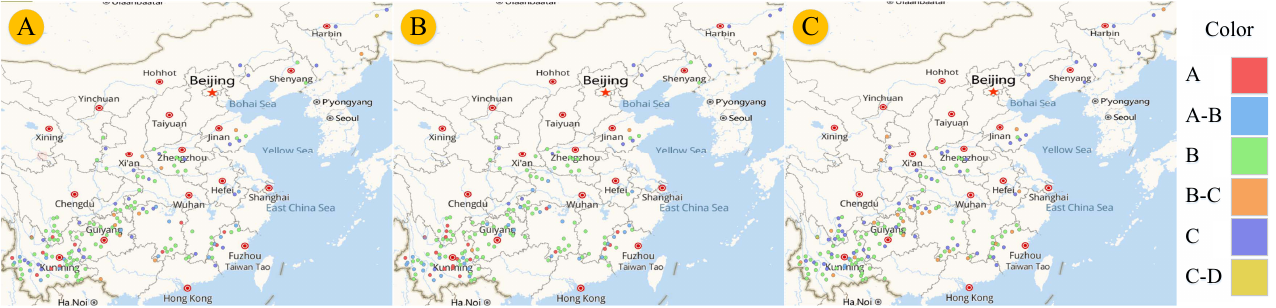
Figure 7. Spatial distribution of industrial usability of flue-cured tobacco leaves. Spatial distribution of industrial usability of ( A ) upper, ( B ) middle, and ( C ) lower tobacco